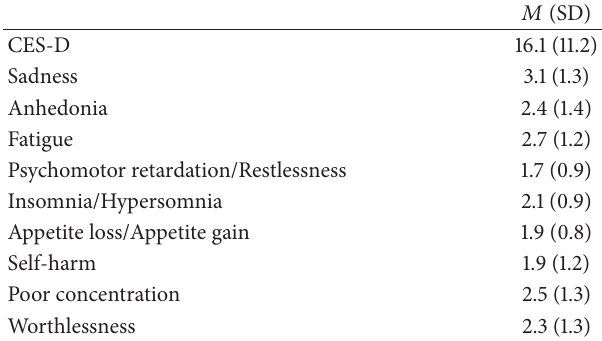
Table 1: Means and standard deviations for the current level of depression (range 0–57) and the symptoms (range 0–4) at the time of the dysphoric episode.